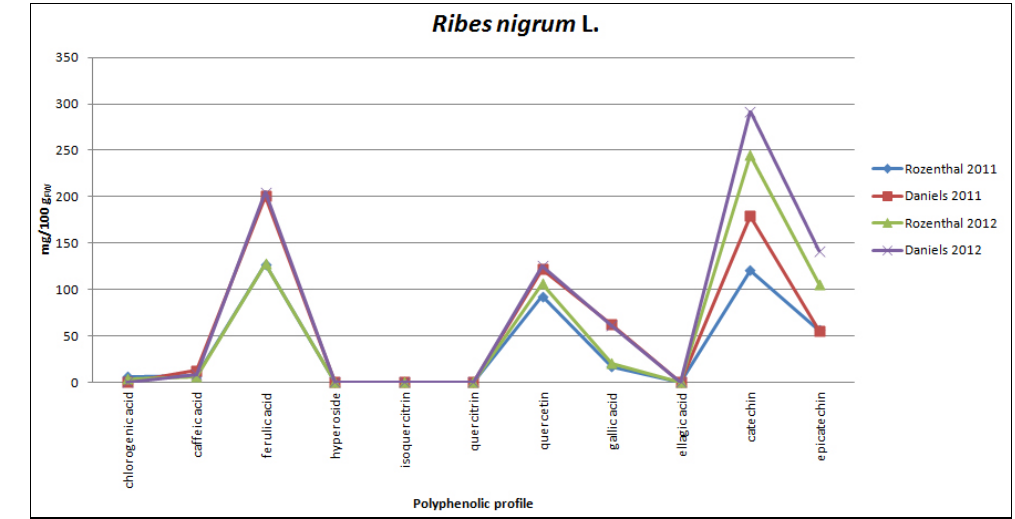
Fig. 4: Ribes nigrum : single polyphenolic profiles in University bud -preparations.